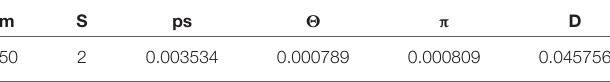
TABLE 6 | Neutrality tests and the estimated parameters of mismatch distribution for populations of S. maximus from Turkish